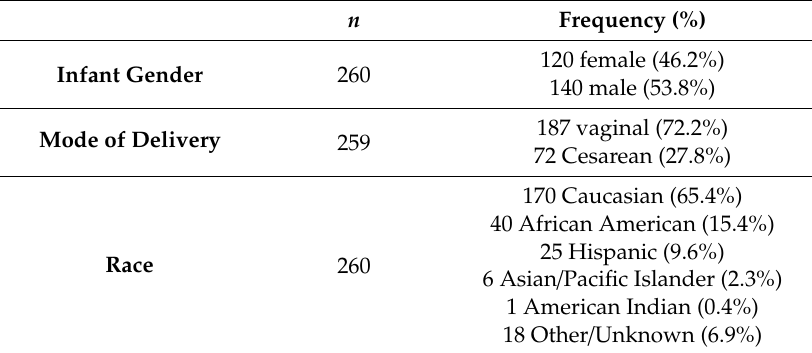
Table 2. Categorical continuous responses of maternal and infant demographic and birth